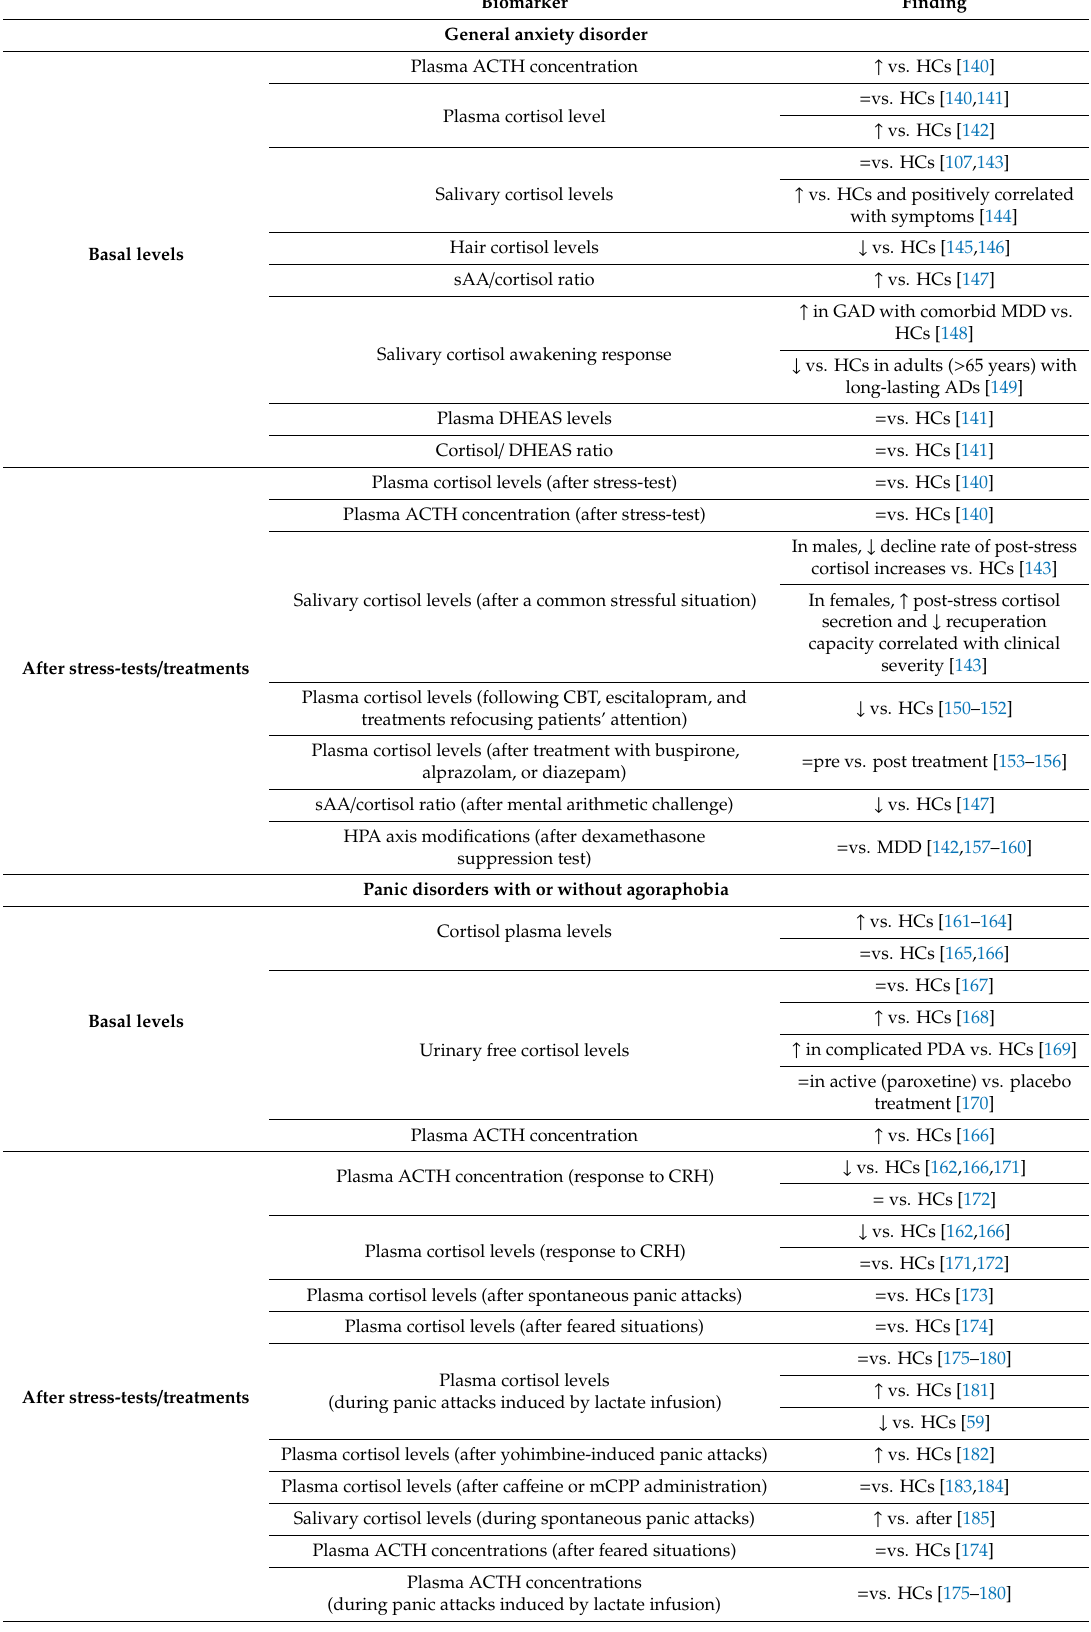
Table 3. Summary of the findings related to the hypothalamic–pituitary–adrenal axis involved in GAD, PDA, and